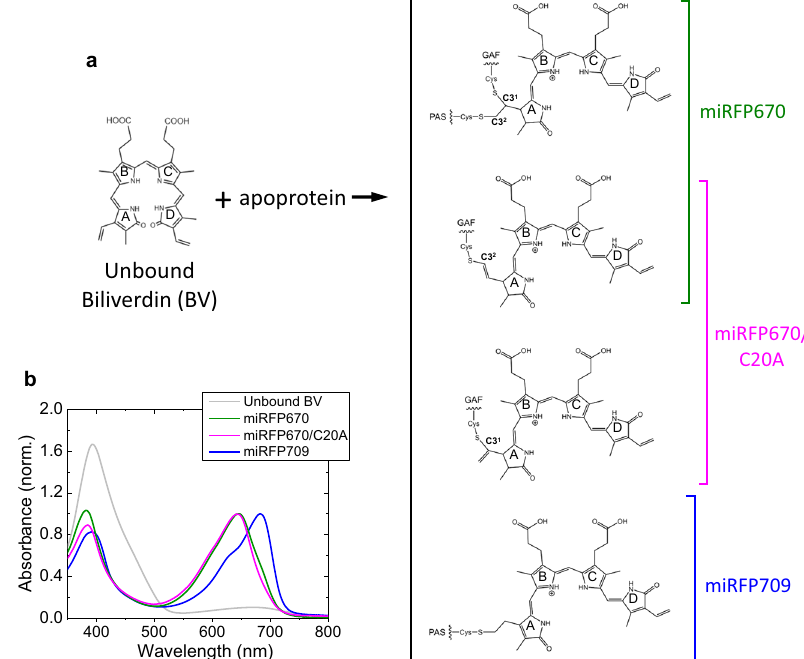
Fig. 1 Biliverdin binding to miRFPs and absorption spectra. a Biliverdin (BV) structures in miRFP670, miRFP670/C20A and miRFP709. The molecular structures are reproduced from Baloban et al. 31 ; b steady-state UV – vis absorption spectra of BV in aqueous buffer solution (gray), miRFP670 (green), miRFP670/C20A (magenta) and miRFP709